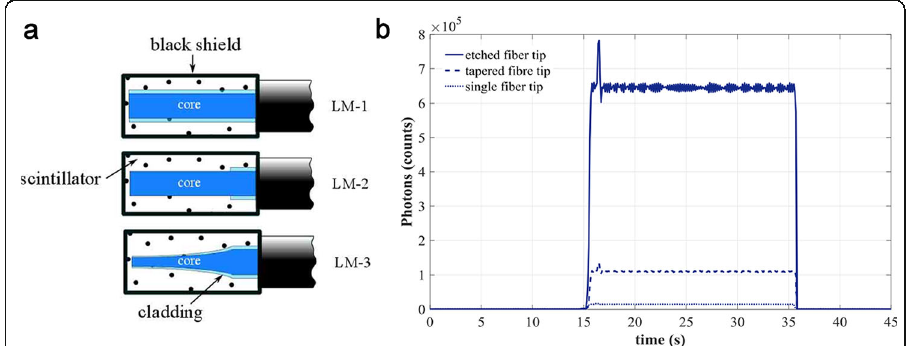
Fig. 7 a Schematic draw of the fabricated transducers LM-1 (plain fiber), LM-2 (etched fiber), and LM-3 (tapered fiber). b Sensor signal recorded for single fiber tip (dotted line), tapered fiber tip (dashed line), and etched fiber tip (solid line)